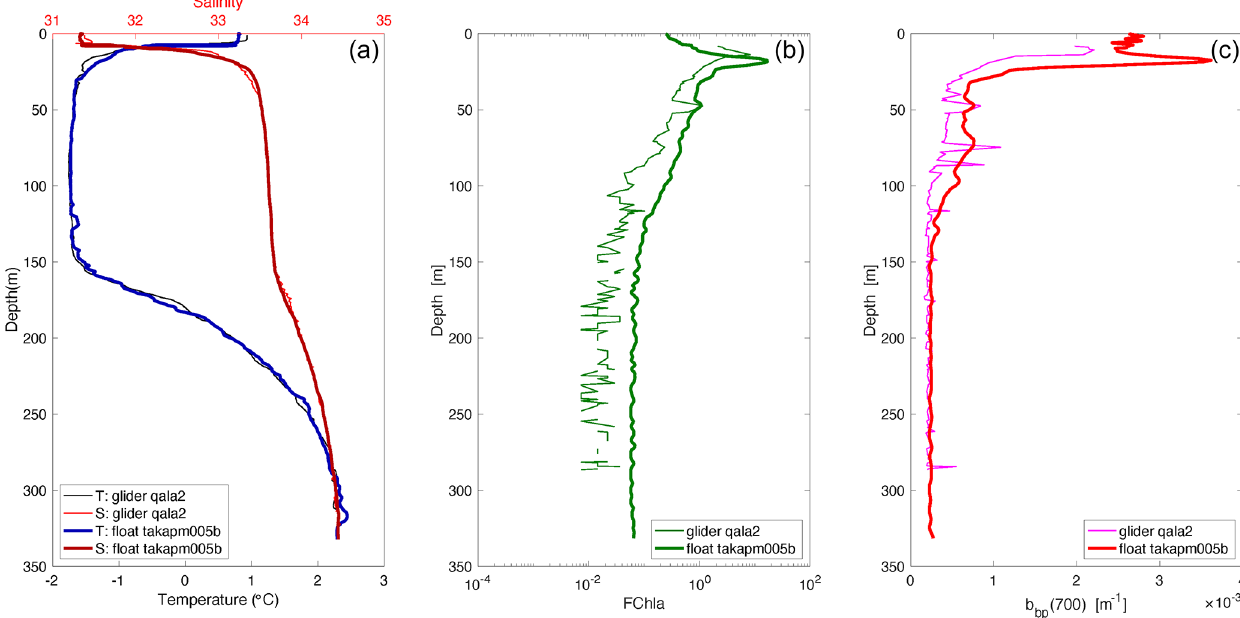
Figure 2. Comparison between salinity (psu, a ), temperature ( ◦ C, a ), chlorophyll fluorescence (relative units, b ), and backscattering at 700nm ( b bp (700), m − 1 , c ); data from the qala2 glider and the takapm005b BioArgo float at their closest common position (Fig.